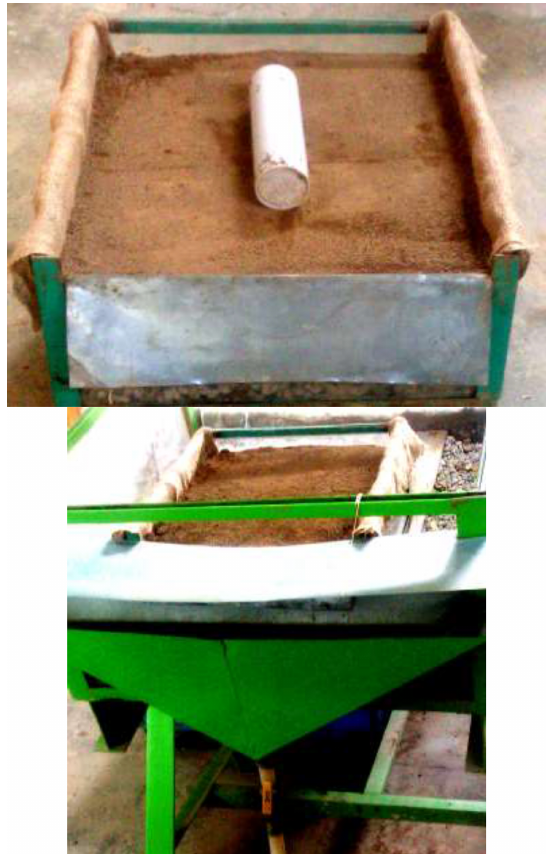
Figure 1. A general view of the experimental setup at the Rainfall and Soil Erosion Simulation Laboratory of Tarbiat Modares Univer- sity,